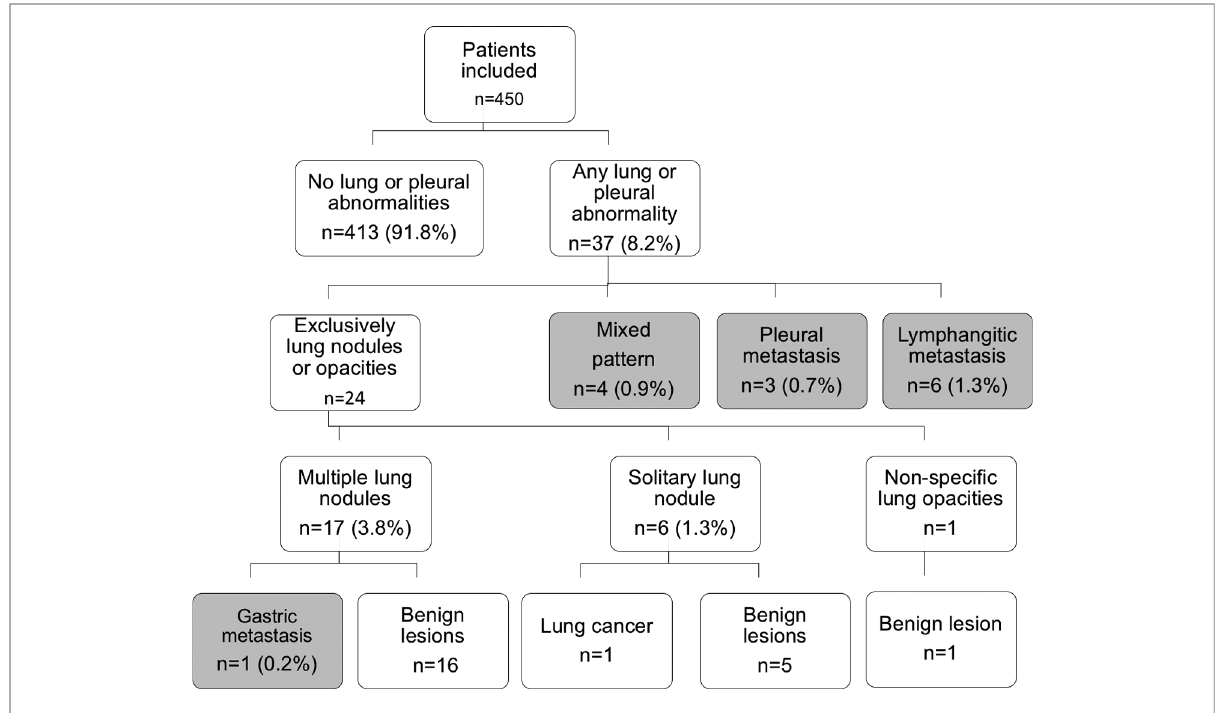
FIGURE 1 Flow chart of included patients. Grey color in the boxes corresponds to the 14 patients that met the criteria for pleural or pulmonary